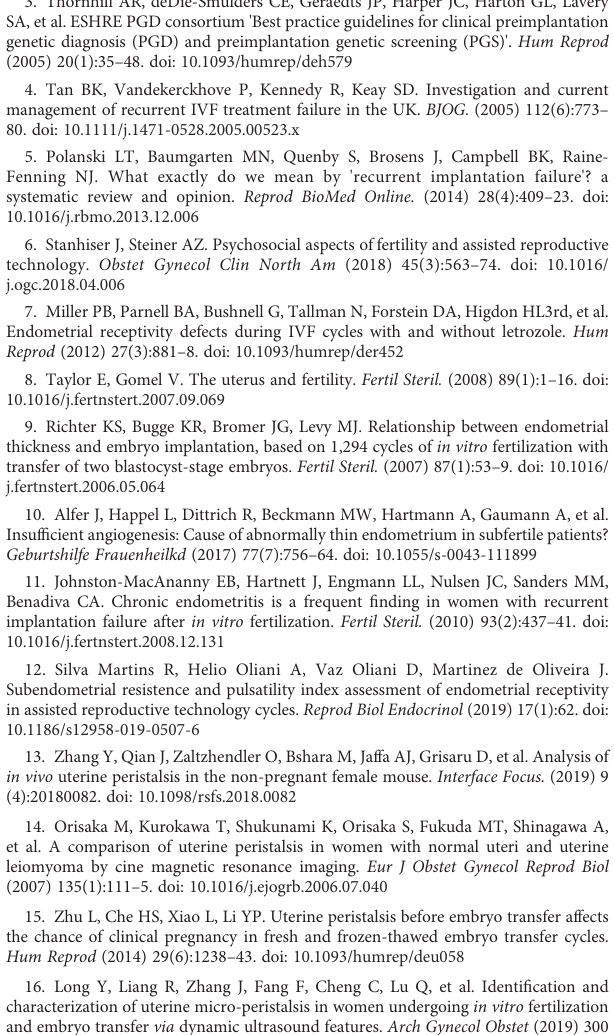
SUPPLEMENTARY FIGURE 2 Forest plots of clinical pregnancy rate.